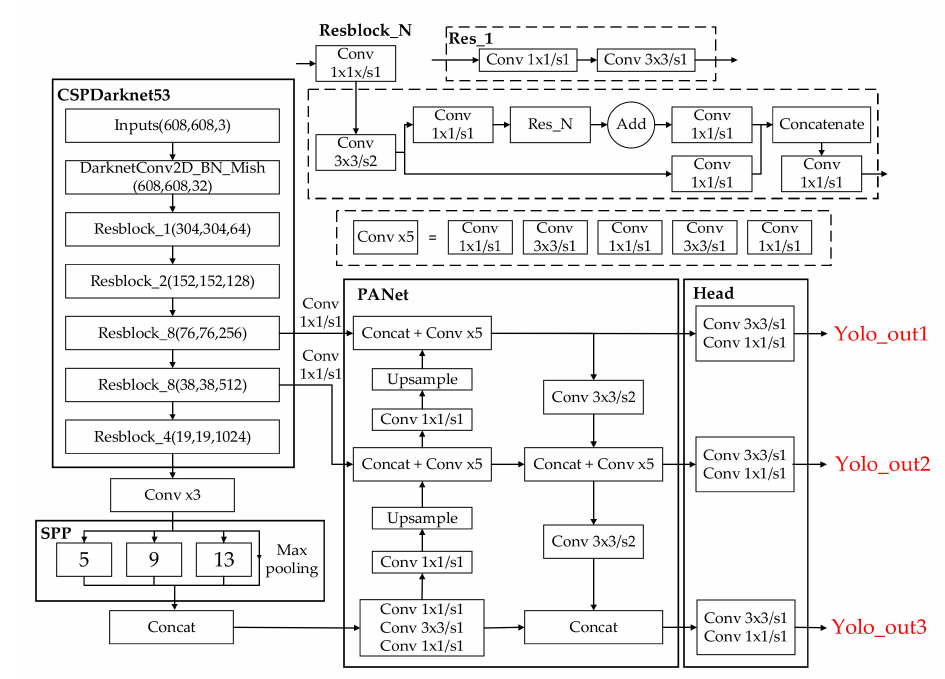
Figure 2. Structure of YOLOv4